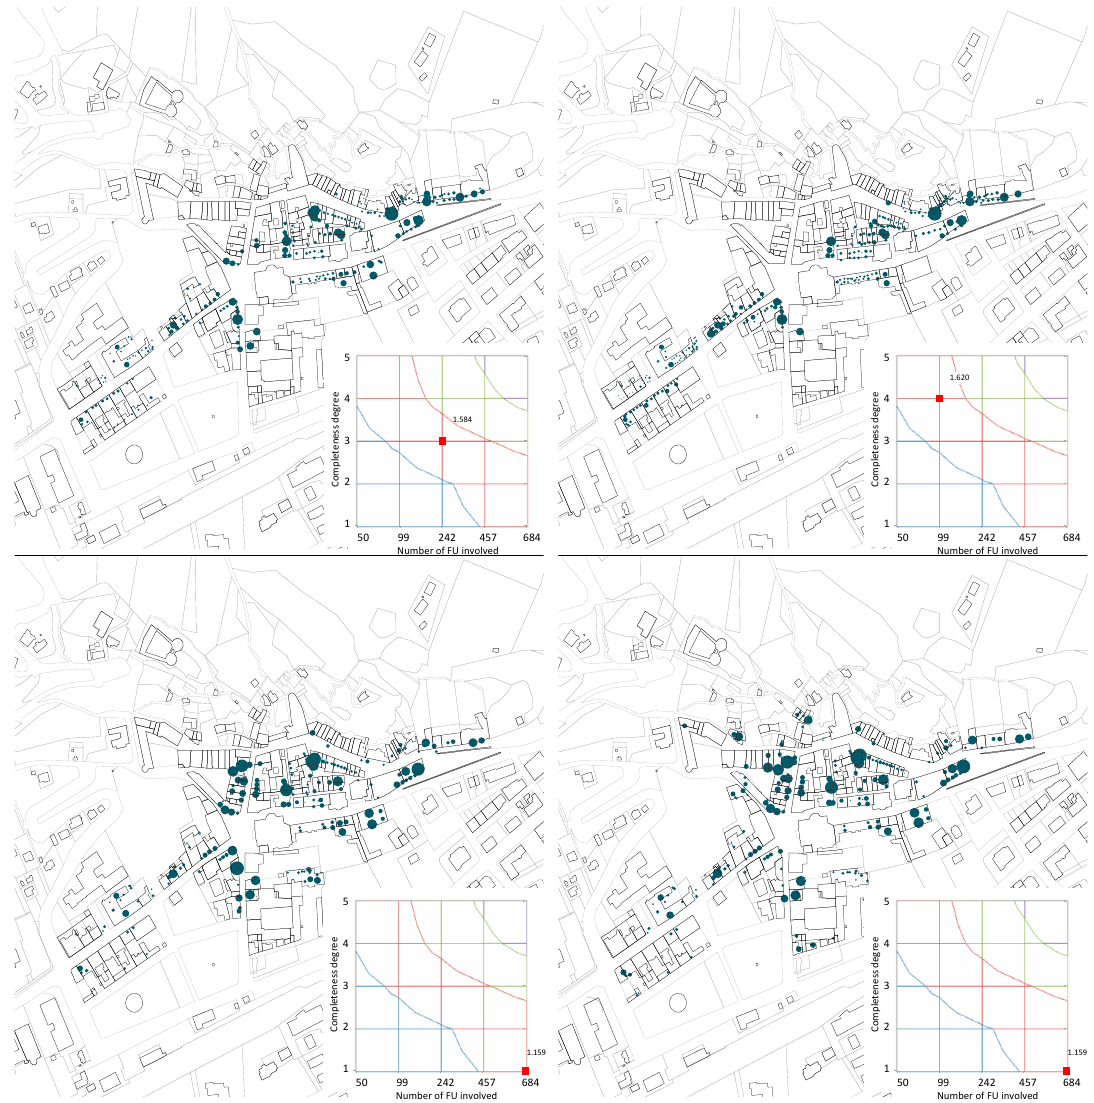
ff erent layouts of the strategies with (approximately) the same total Figure 5. Mapping of the different layouts of the strategies with (approximately) the same total cost. Figure 5. Mapping of the di